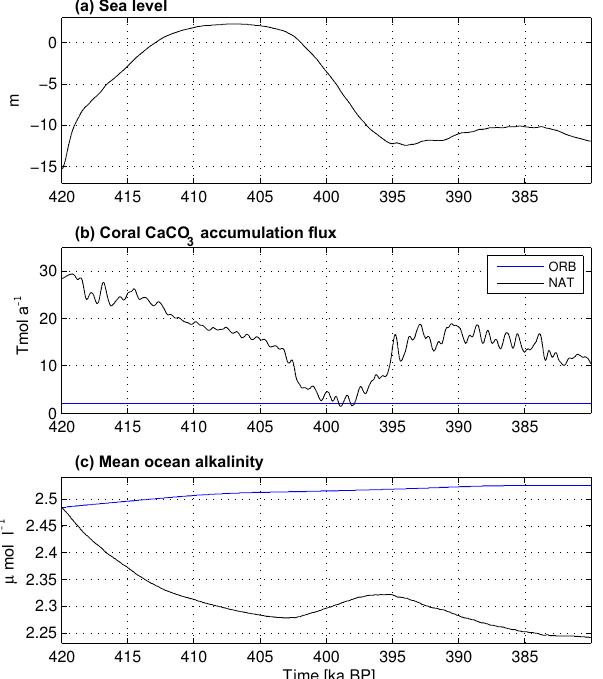
Figure 13. Sea level forcing (a) , shallow-water CaCO3 accumula- tion flux (b) and mean ocean alkalinity (c) in the MIS 11 experi- ments. Plots have been smoothed for